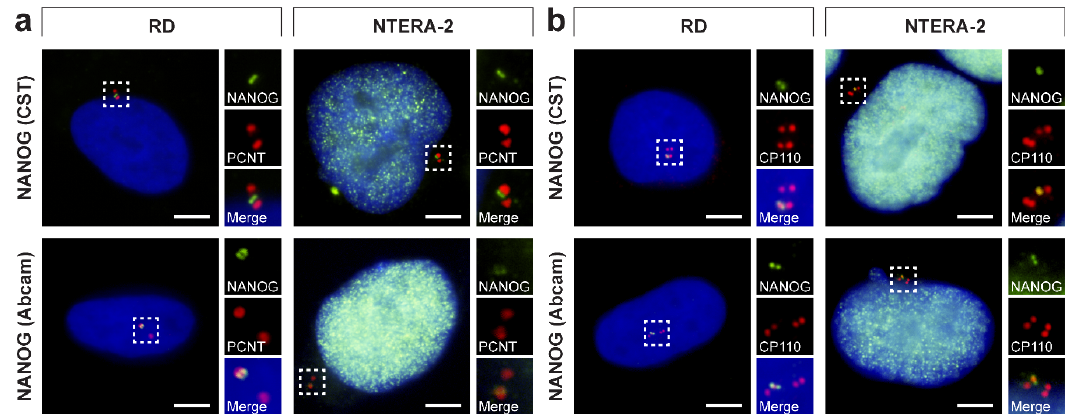
Figure 7. Interaction of NANOG with only one centriole within a cell. NANOG (green; #4903, Cell Signaling Technology (CST) and #ab109250, Abcam) was detected in only ( a ) one centrosome (pericentrin, PCNT; red) and ( b ) one centriole (CP110; red) during the interphase of RD and NTERA-2 cells. The nuclei were counterstained with Hoechst 33342 (blue). For each image, a region of interest is indicated by the dashed box, and the respective close-ups are provided on the right. Scale bars, 5 μ m.